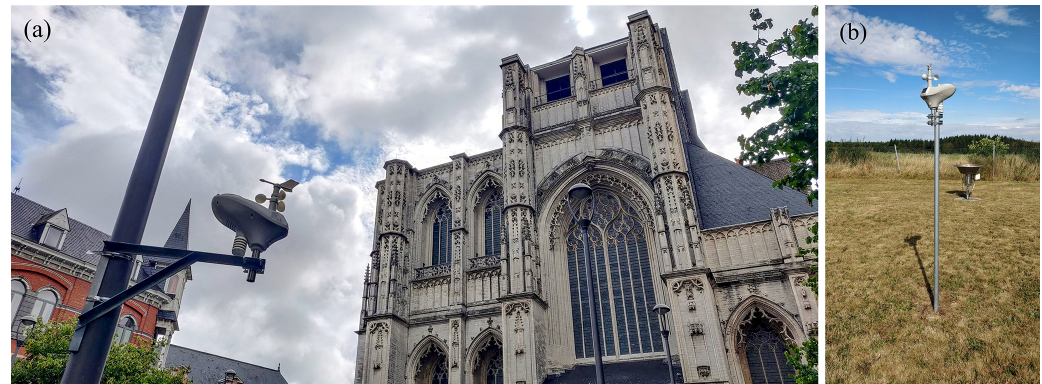
Figure 1. The WH2600 wireless digital weather station outdoor unit (a) at Mathieu de Layensplein in Leuven (LC-105) and (b) next to the official AWS equipment in Humain (LC-R05) (photograph credit: Maarten Reyniers).